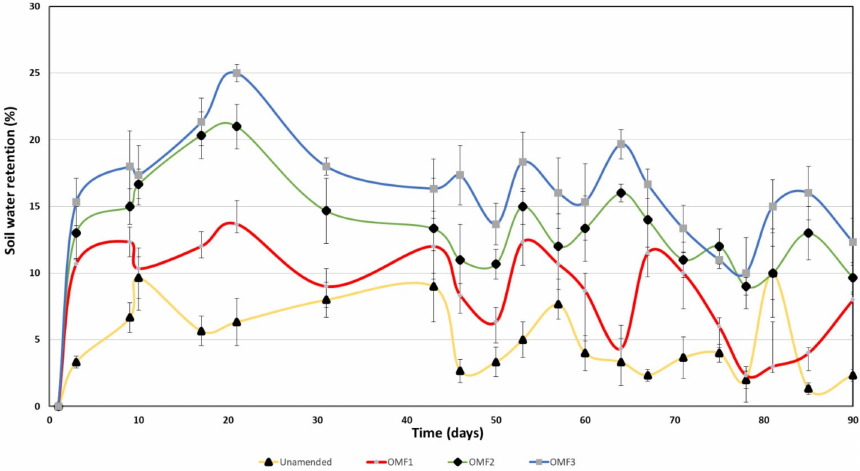
Figure 3. Effect of organo-mineral application formulations on maize agro-physiological